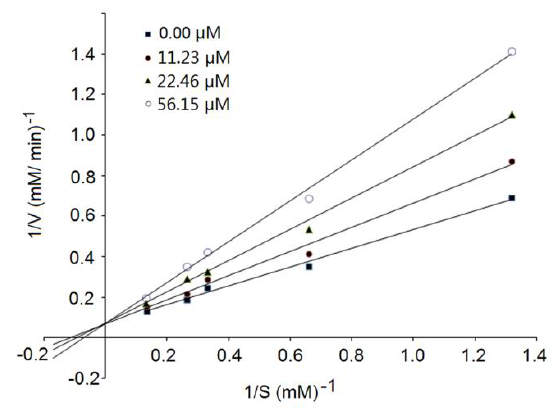
Figure 5. The Lineweaver–Burk plots of the ACE inhibition of RWDISQPY.